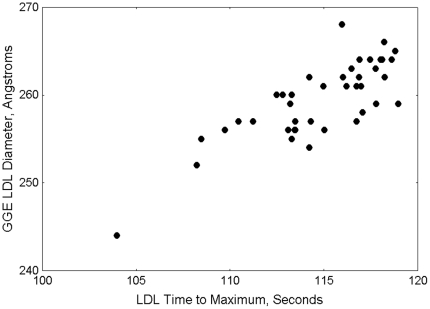
Typical relationship of average LDL particle size by gradient gel electrophoresis vs. VAP LDL peak maximum time density parameter; Pearson correlation coefficient, r = 0.80, p<10−6.